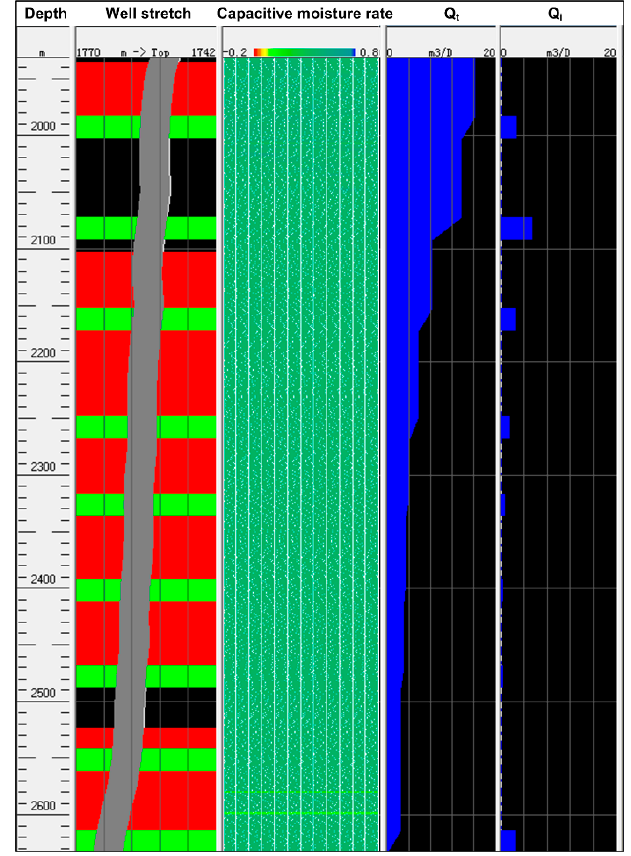
Figure 1. The production profile from the PLT results of an MFHWs in tight reservoirs [13,48].